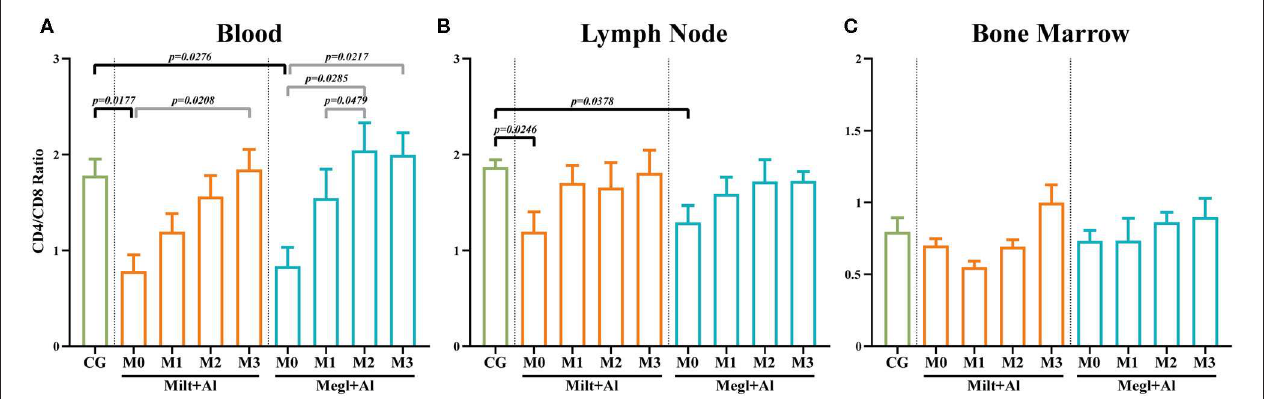
FIGURE 5 | CD4/CD8 ratio in the blood (A) , lymph node (B) , and bone marrow (C) of healthy [control group (CG)], sick (M0), and treated dogs (M1, M2, and M3). Results of 22 dogs are represented by mean values ± SEM. The non-parametric Kruskal–Wallis test (one-way ANOVA on ranks) with Dunn’s post hoc test was used for statistical comparisons between treatment groups and the CG. The repeated measures ANOVA test with Tukey’s post hoc test was used for statistical comparisons inside each treatment group. p -values are indicated in every statistically significant comparison.